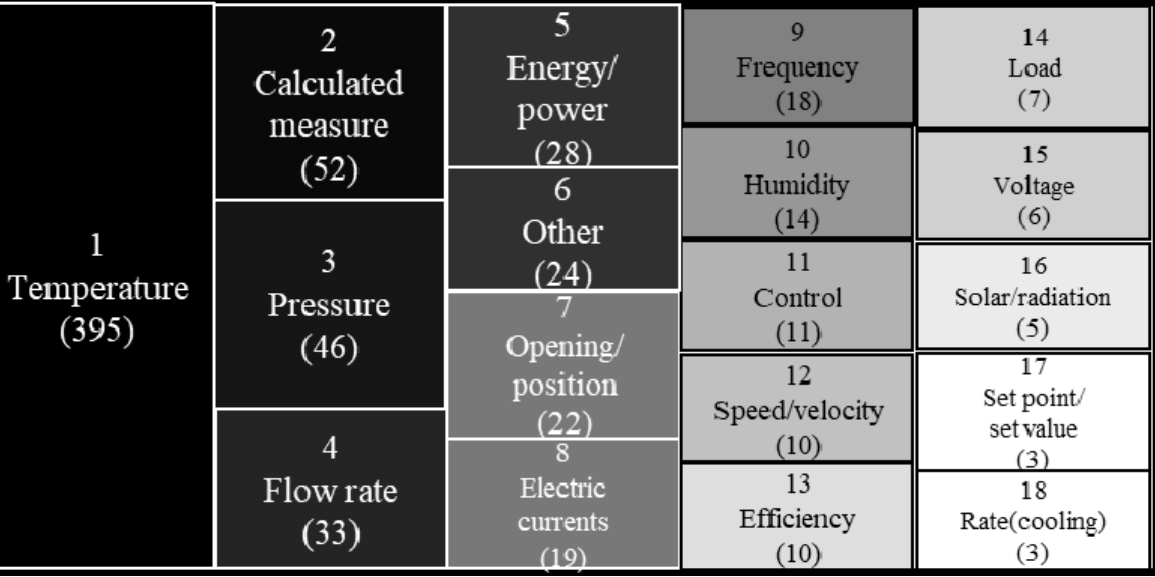
Figure 4. Common features selected for AFDD of HVAC (18 categories formed for 706 features used in the analyzed literature and the numbers in brackets represent the frequency of occurrence in the literature).